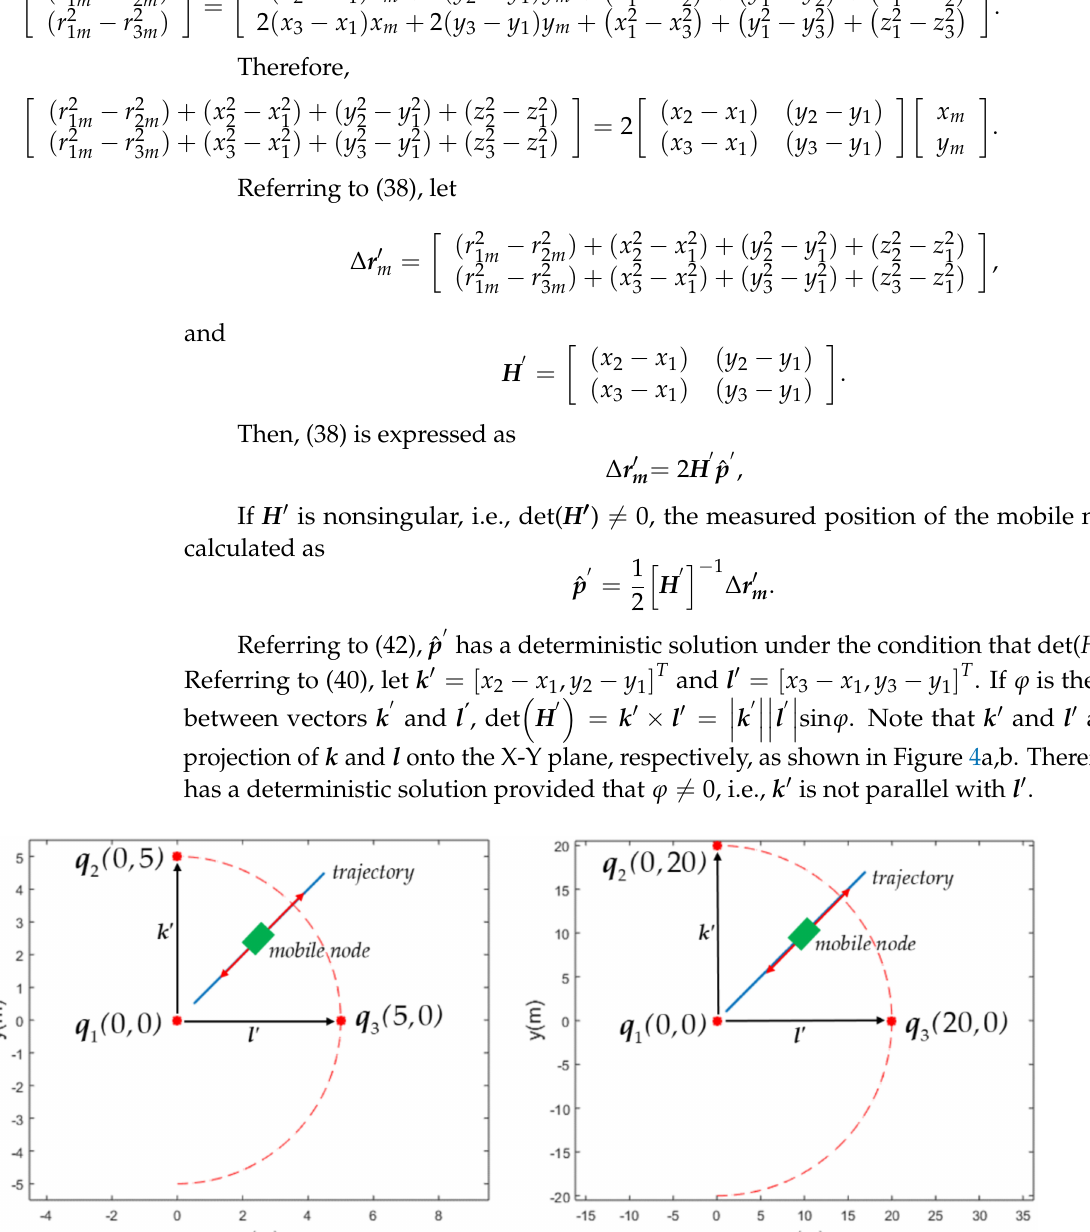
, q and q onto the X − Y plane and the moving trajectory of the 1 2 3